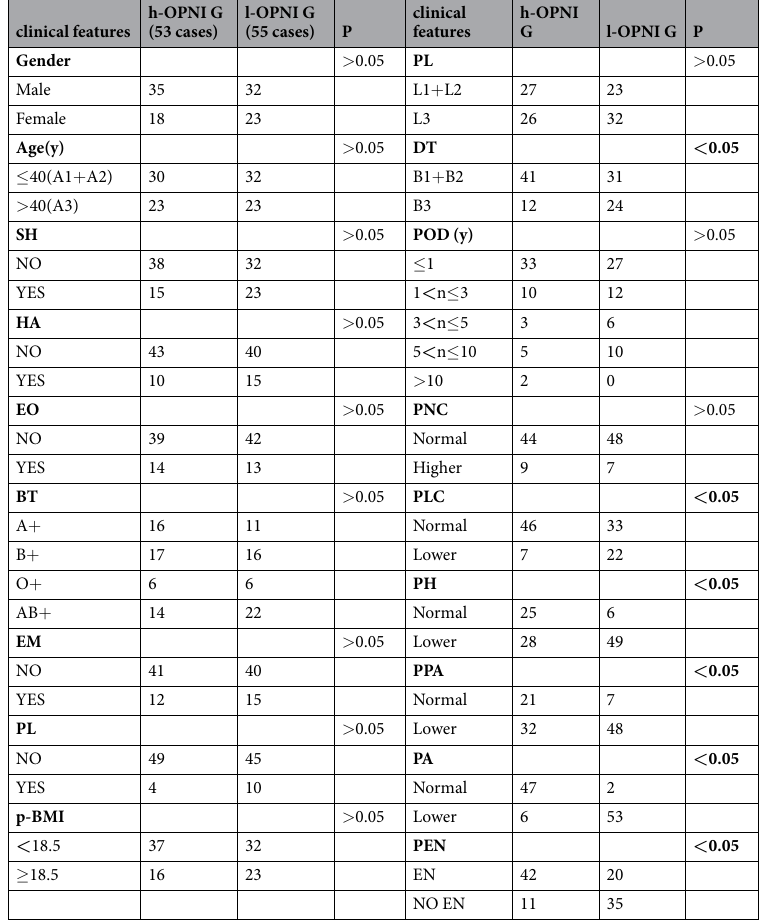
Table 3. Clinical features in the high OPNI group (n = 53) versus the low OPNI group (n = 55). h-OPNI G , high OPNI group; l-OPNI G , low OPNI group; SH , smoking history; HA , history of appendectomy; POD , preoperative duration; PL , primary lesion; DT , disease type (B3 or not); EM , extraintestinal manifestations; PL , perianal lesions; EO , emergency operation; p-BMI , preoperative BMI; BT , blood type; PH , preoperative haemoglobin; PNC , preoperative neutrophil count; PLC , preoperative lymphocyte count; PA , preoperative